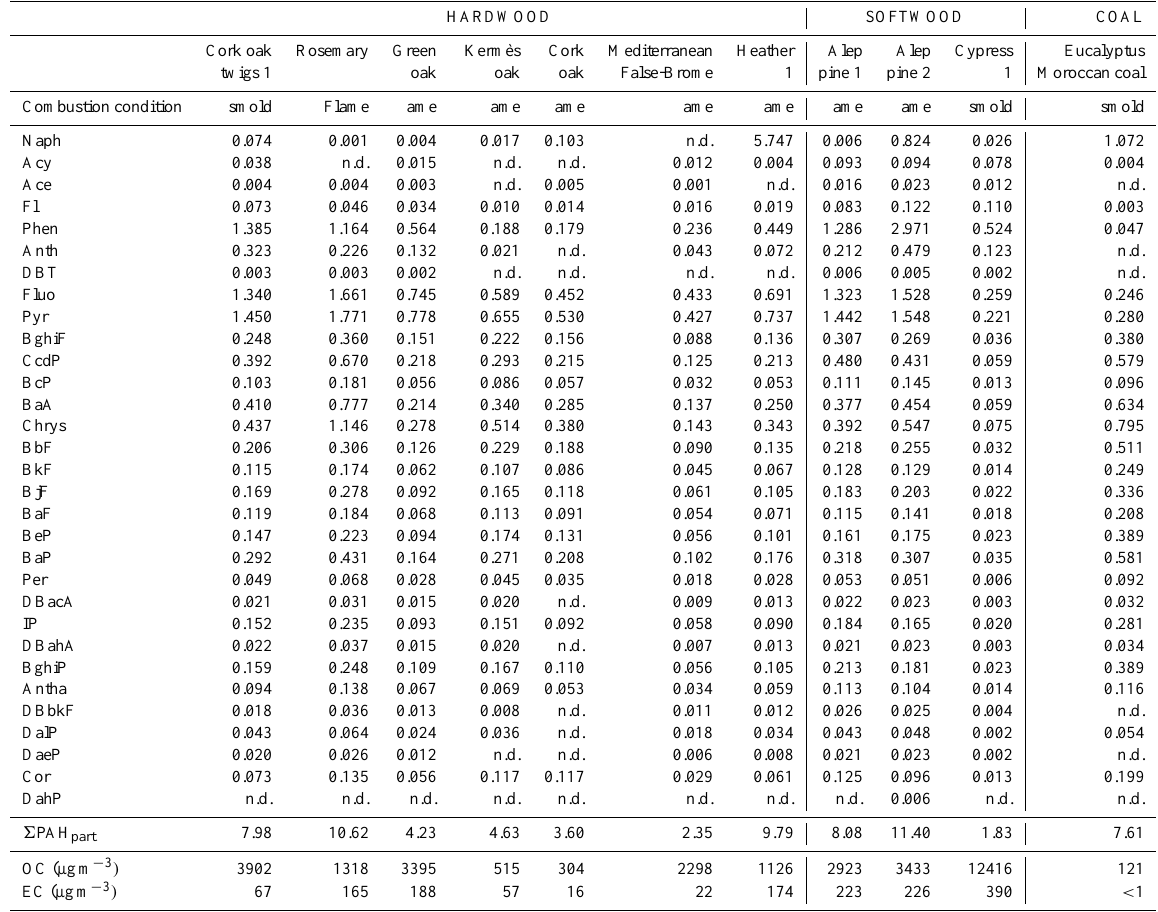
Table 4. PAH concentrations in PM 2 . 5 from wood combustion (mgg − 1 of